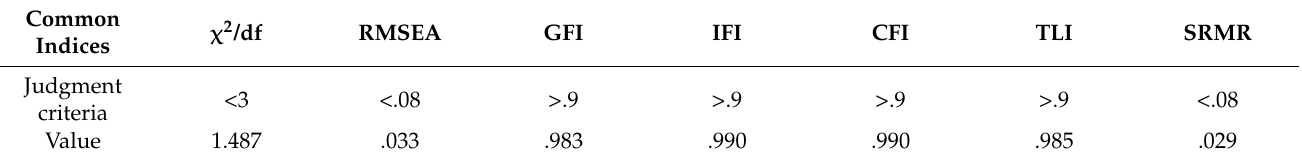
Table 8. Second-Order CFA model fit.